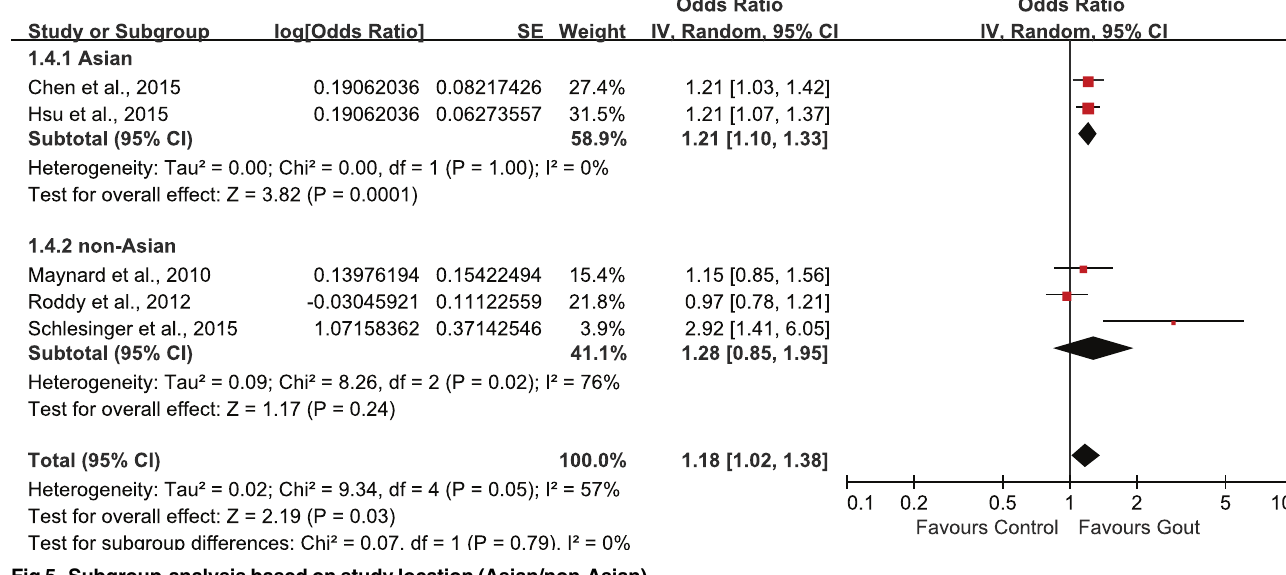
Fig 5. Subgroup-analysis based on study location